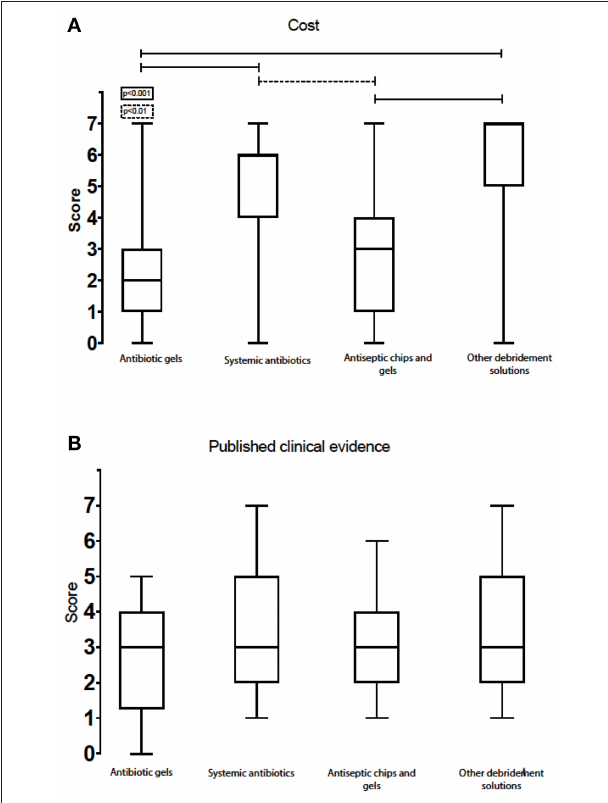
FIGURE 9 | Box-plot with score of cost (A) (lower numbers represent most expensive option) and published clinical evidence (B) for the various chemical remedies.